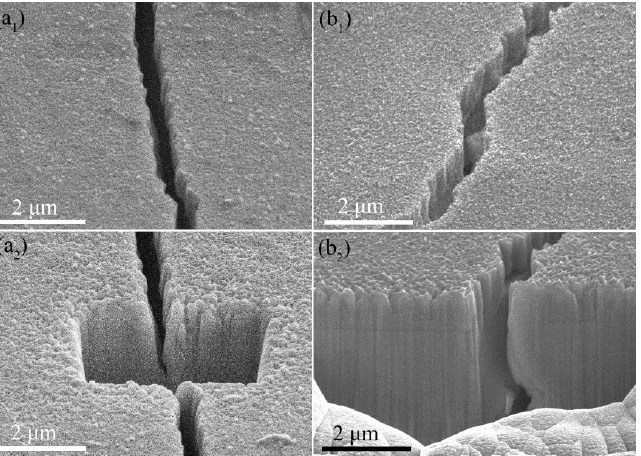
Figure 4. SEM images of the W-150W-1 film ( a 1 , a 2 ) at the absorbed power density of 0.43 GW/m 2 , and the W-50W-1 film ( b 1 , b 2 ) at 0.28 GW/m 2 .